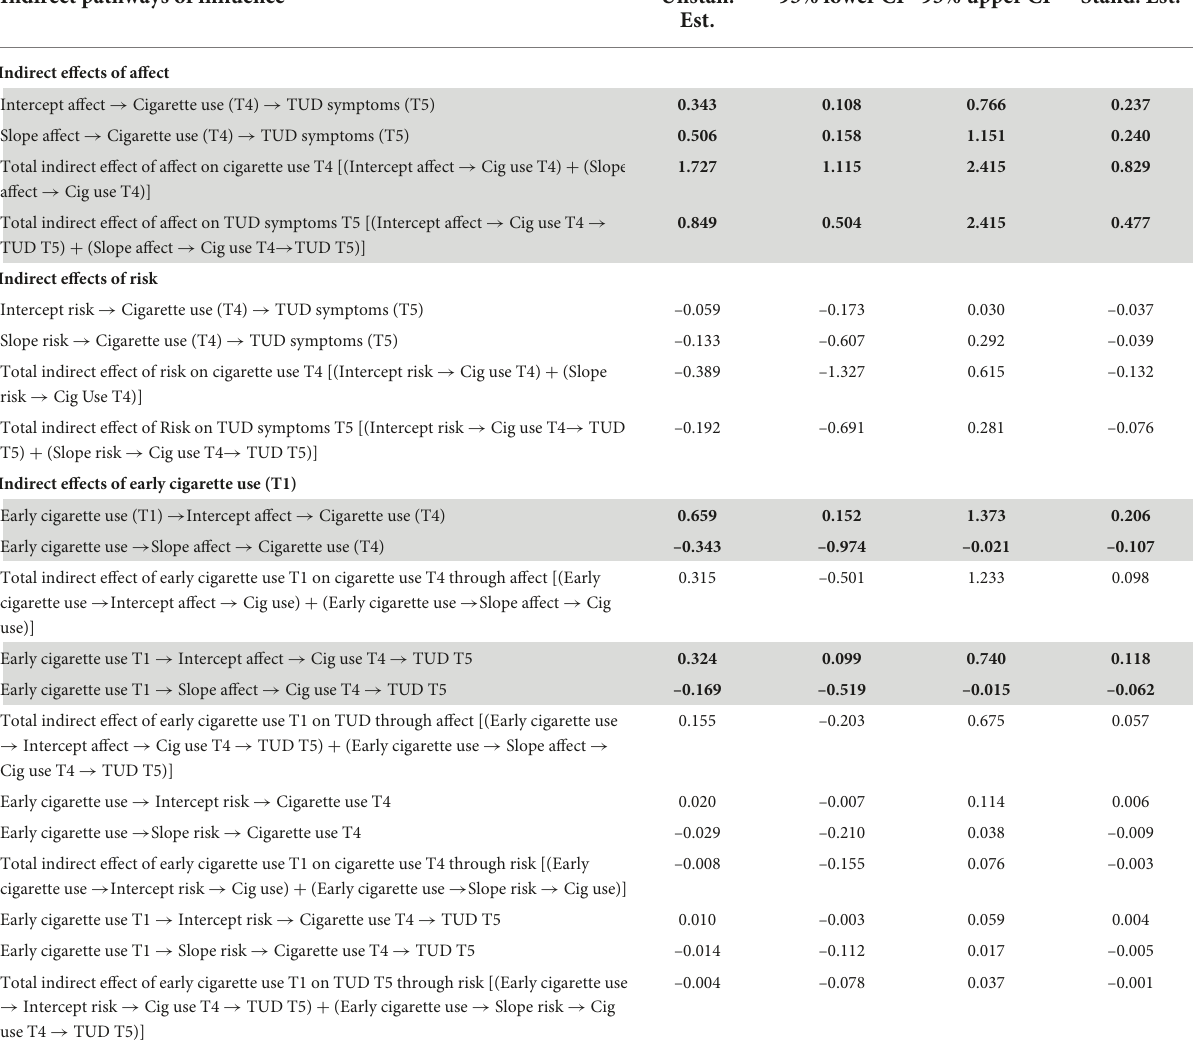
TABLE 4 Selected indirect effects; 95% confidence intervals (CIs) produced by using the adjusted bootstrap percentile method to adjust for bias in the distribution of indirect effects. Indirect pathways of influence Unstan.